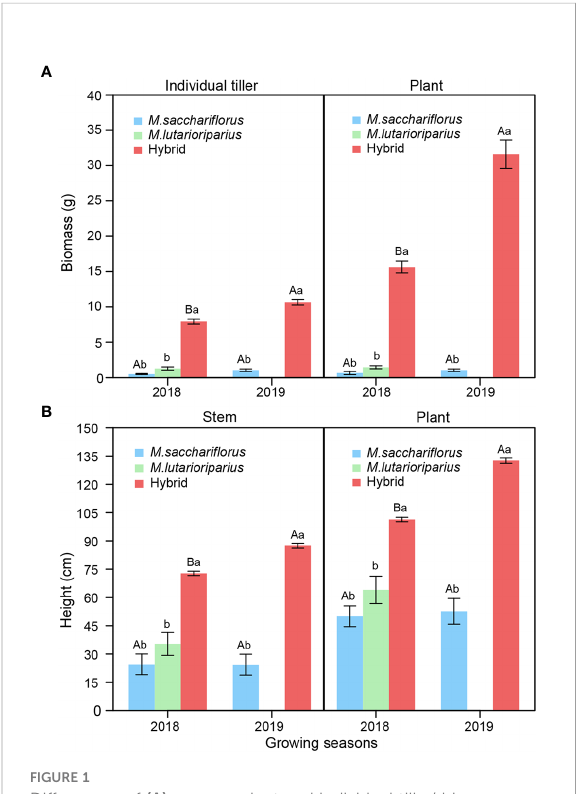
FIGURE 1 Differences of (A) average plant and individual tiller ’ biomass, (B) average plant and stem height between measuring hybrid and parent individuals in two consecutive growth seasons. Different capital letters A and B represent a signi fi cant difference of plant and individual tiller ’ biomass, and plant and stem height between two years at P <0.05 level, respectively. Different lowercases a and b represent a signi fi cant difference between M. sacchari fl orus , M. lutarioriparius and their hybrids at P <0.05 level, respectively. Error bars indicate standard error of 333 surviving hybrid individuals, 5 and 3 surviving female parent individuals in both 2018 and 2019, and 10 surviving male parent individuals in 2018,